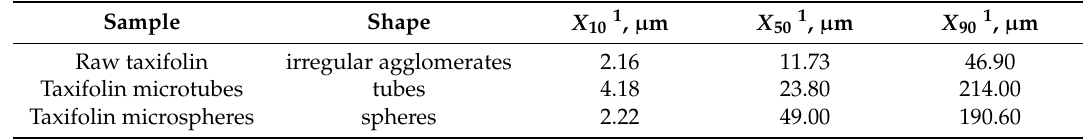
Table 1. Morphological parameters of di ff erent taxifolin forms.